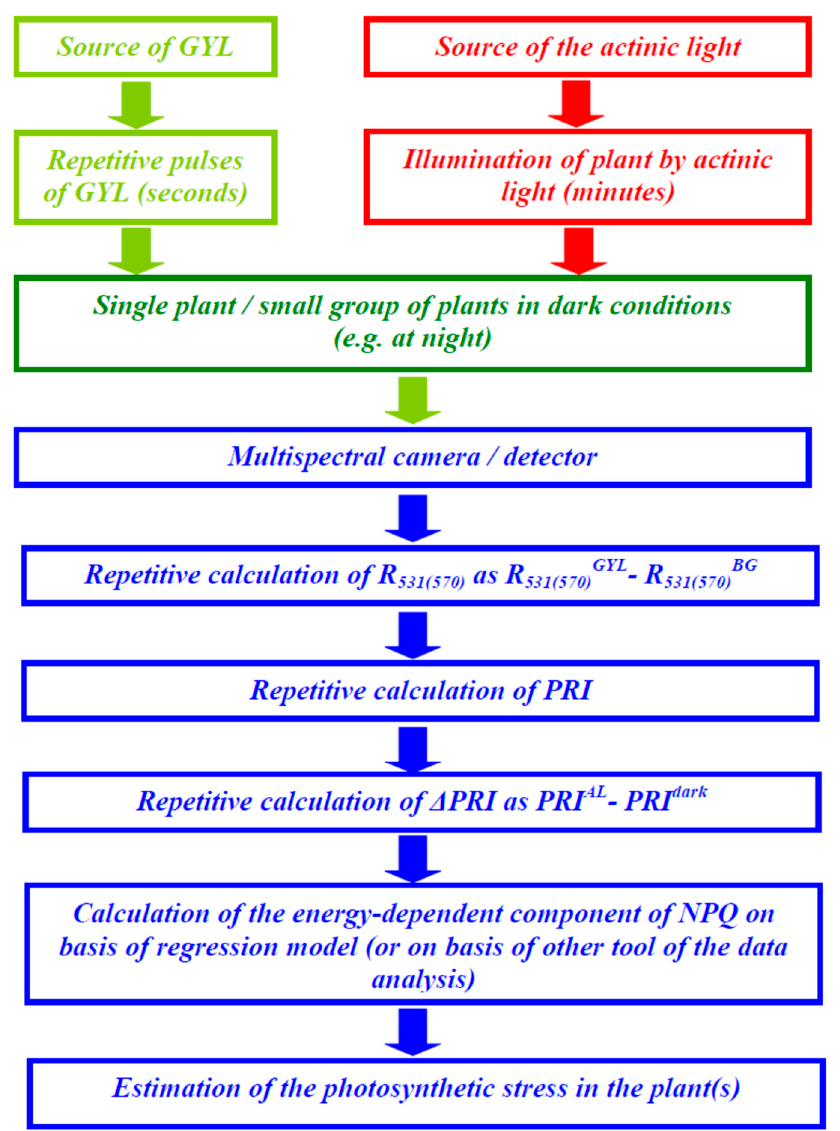
Figure 8. A hypothetical schema of the estimation of the photosynthetic stress in plants on the basis of repetitive GYL pulses and illumination by AL. R 531(570) GYL and R 531(570) BG are reflected light at 531 (570) nm during the GYL pulse and before this pulse. PRI AL and PRI dark are the PRI measured during the AL illumination and before the illumination. PRI is calculated as R 531 − R 570